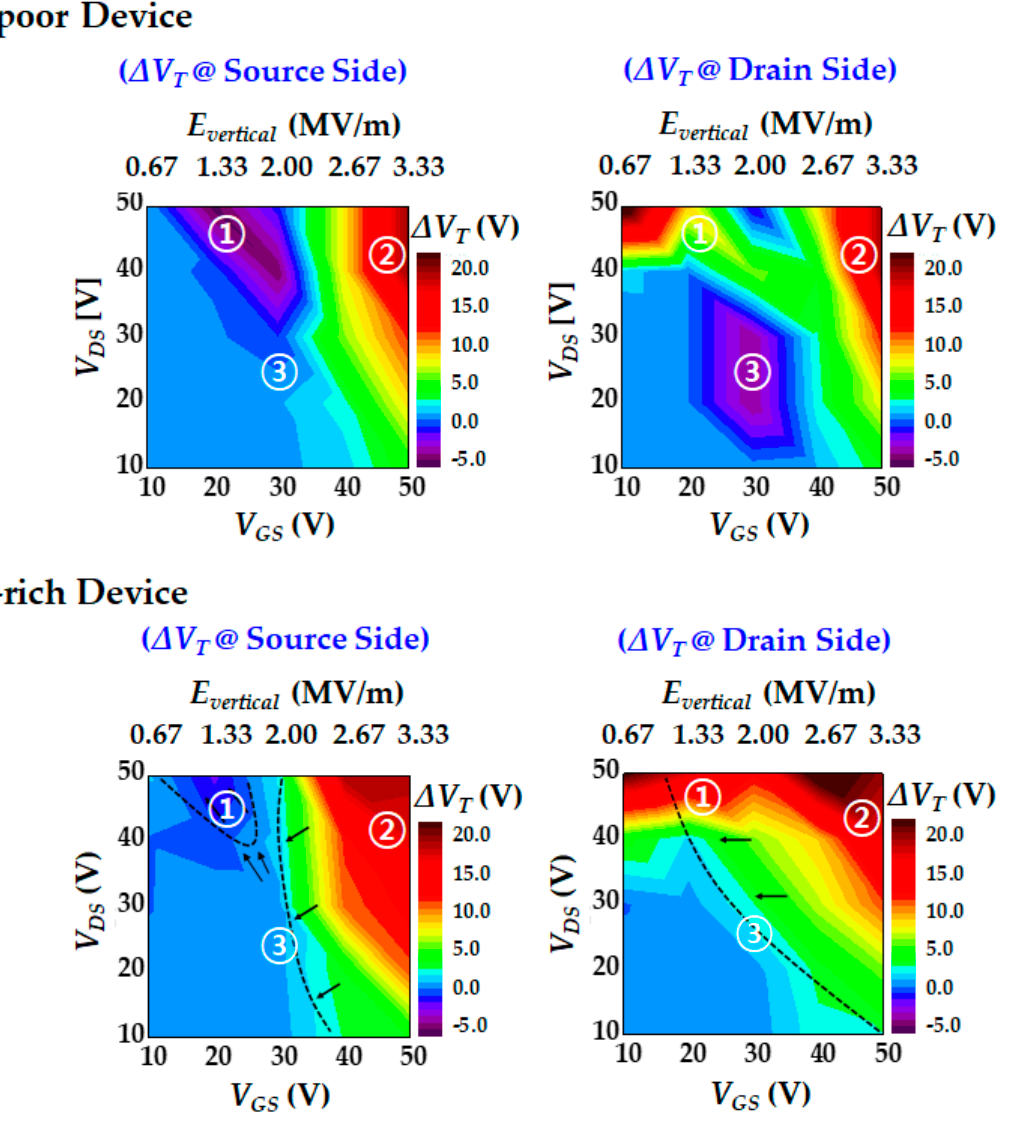
Figure 6. V T shift results after various stress bias: ( a ) O-poor device characteristic; ( b ) O-rich device characteristic.